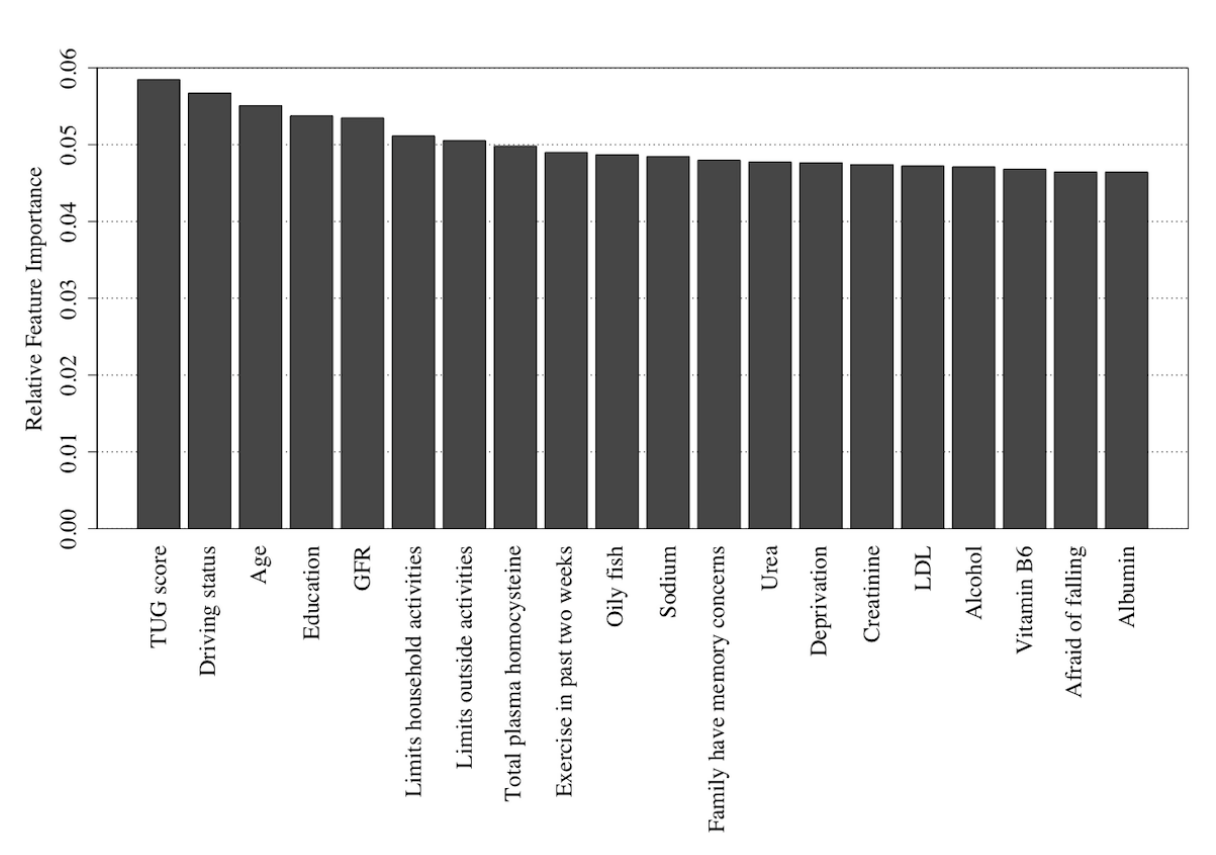
Figure 10. The 20 most important features for classification of the Repeatable Battery for the Assessment of Neuropsychological Status score as detected using feature permutation using a Naïve Bayes classifier. GFR: glomerular filtration rate; LDL: low-density lipoprotein; TUG: Timed Up and